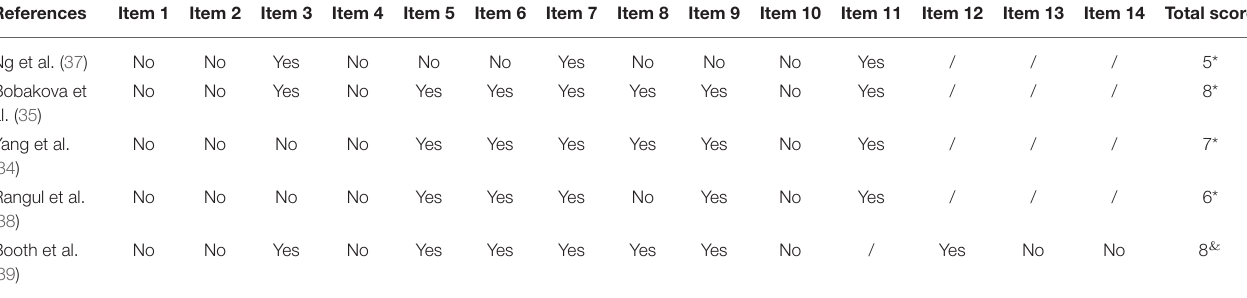
TABLE 3 | Methodological quality assessment for test-retest reliability of the included studies.